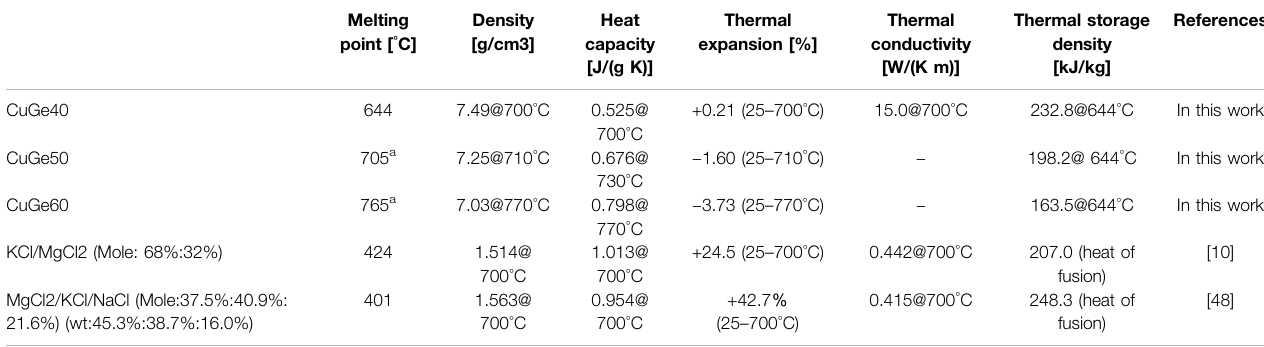
TABLE 2 | Comparison of thermophysical properties for CuGe alloys and molten salts in a liquid